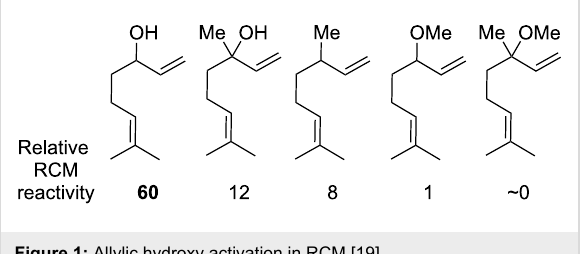
A number of possible explanations for the rate acceleration due to allylic hydroxy groups in olefin metathesis have been proposed [19]. For example: The preassociation of the alcohol takes place at the ruthenium center through the rapid and revers- ible exchange of the alkoxy a for chloride ligand to give a com- plex such as 5 , or the exchange of the alcohol for a phosphine ligand exchange to generate 6 . The anionic complex 7 could also promote the reaction (Figure 2). Hydrogen bonding